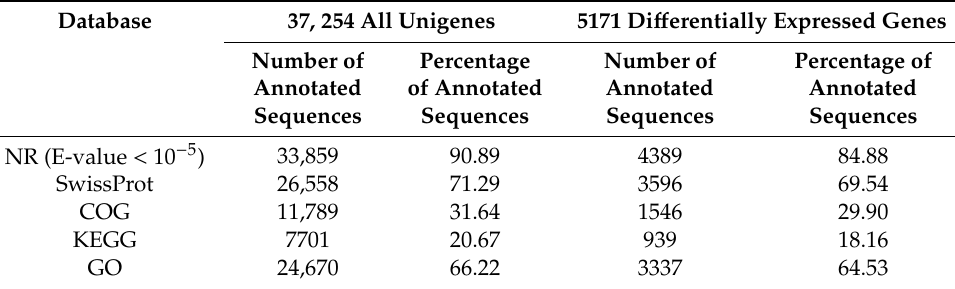
Table 2. Summary of functional annotation of the di ff erentially expressed